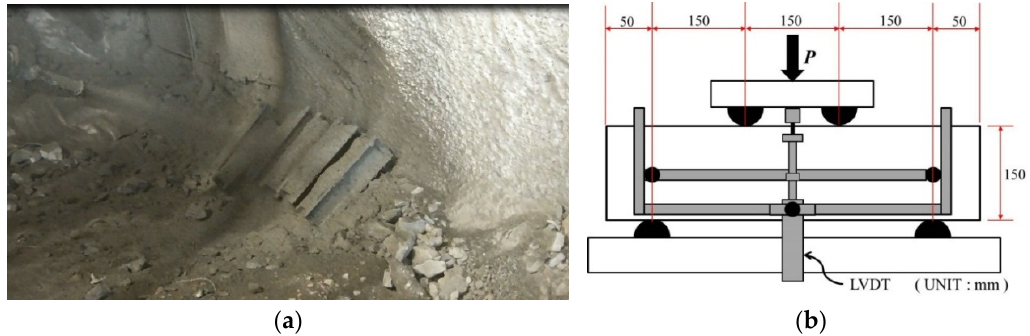
Figure 7. ( a ) Shotcrete specimen fabrication; ( b ) specimen geometry and test setup.